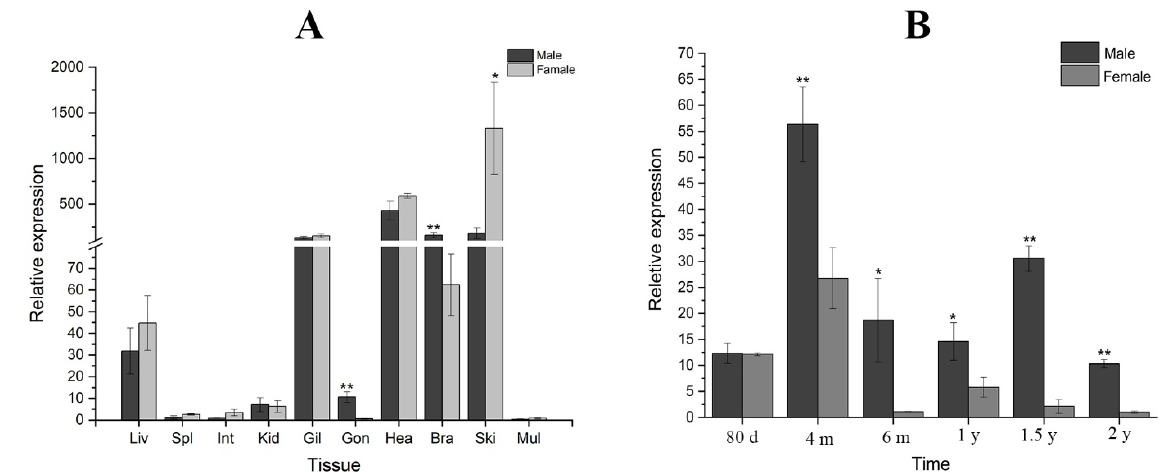
Figure 4. Relative expression of cyp26b1 in Chinese tongue sole tissues. ( A ), relative expression of cyp26b1 in different tissues. ( B ), relative expression of cyp26b1 in various development stages. Values are indicated as means ± SEM (N = 3). ‘*’ refers to statistically significant differences ( p < 0.05), and ‘**’ means very significant differences ( p < 0.01).